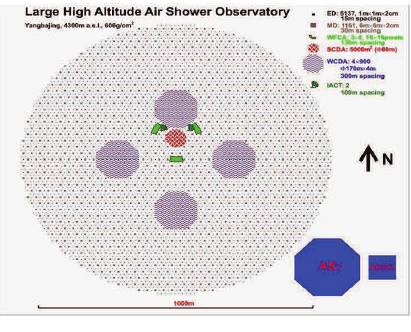
Figure 7: Layout of the LHAASO experiment.